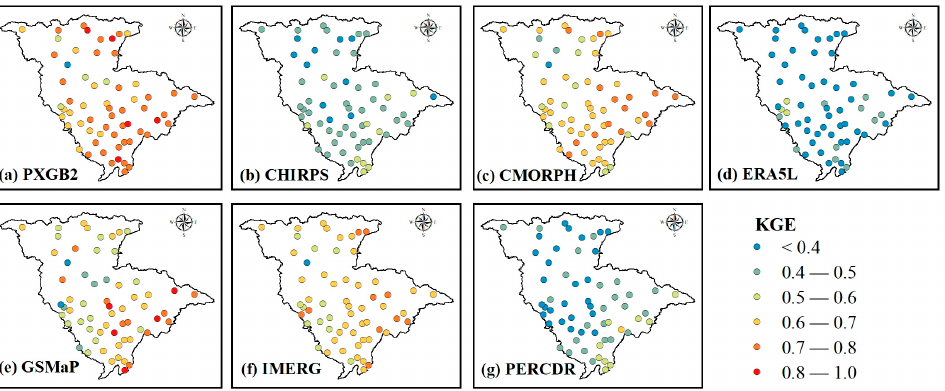
Figure 3. The spatial distribution of KGE for precipitation products compared with rain gauges.